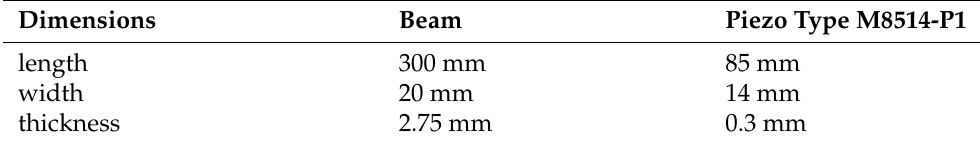
Table 1. Dimensions of the composite beam and applied element of piezo from Smart Material [29].